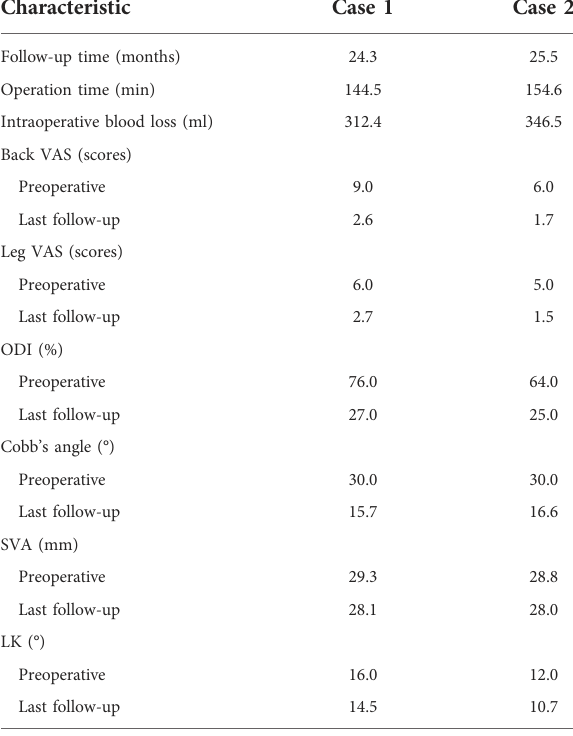
TABLE 1 General data and operation-related indexes of two patients.